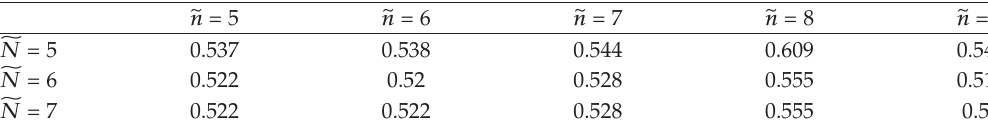
Table 4: Dimensionless amplitude of limit-cycle oscillations (cid:3) w/h (cid:6) of a cantilevered square plate in dimensionless coordinates (cid:3) x/a,y/b (cid:6)(cid:9)(cid:3) 1,0.75 (cid:6) and dynamic pressure λ (cid:9) 150 regarding the order of (cid:31) N (cid:6) approximation polynomial series (cid:3) M i (cid:9) N i (cid:9) and number of in-plane and out-of-plane selected vibration mode shapes for reduced model (cid:3) n in (cid:9) n out (cid:9) n (cid:6) .